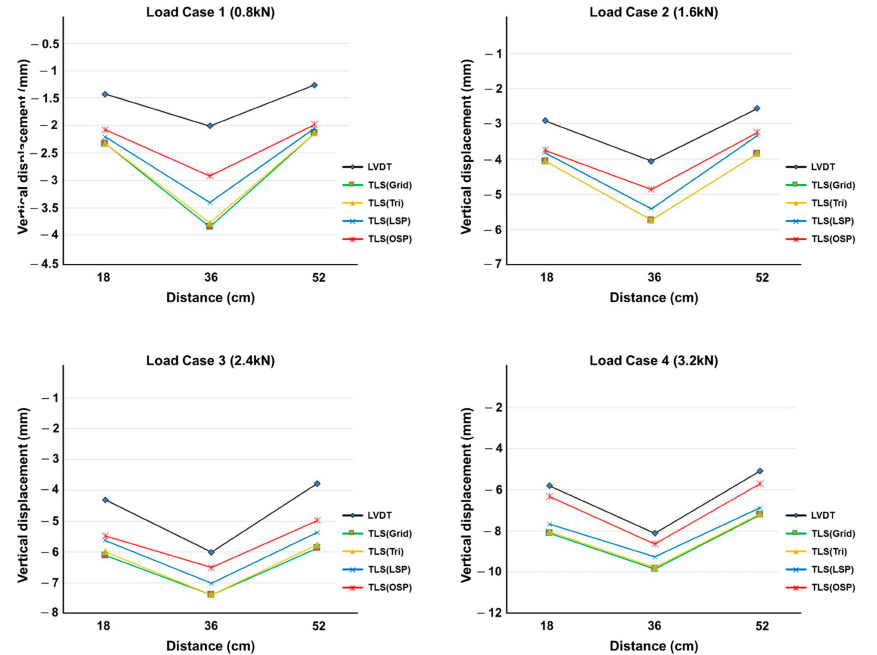
Figure 11. Comparison of vertical displacement between LVDT and the four methodologies (10 mm specimen).